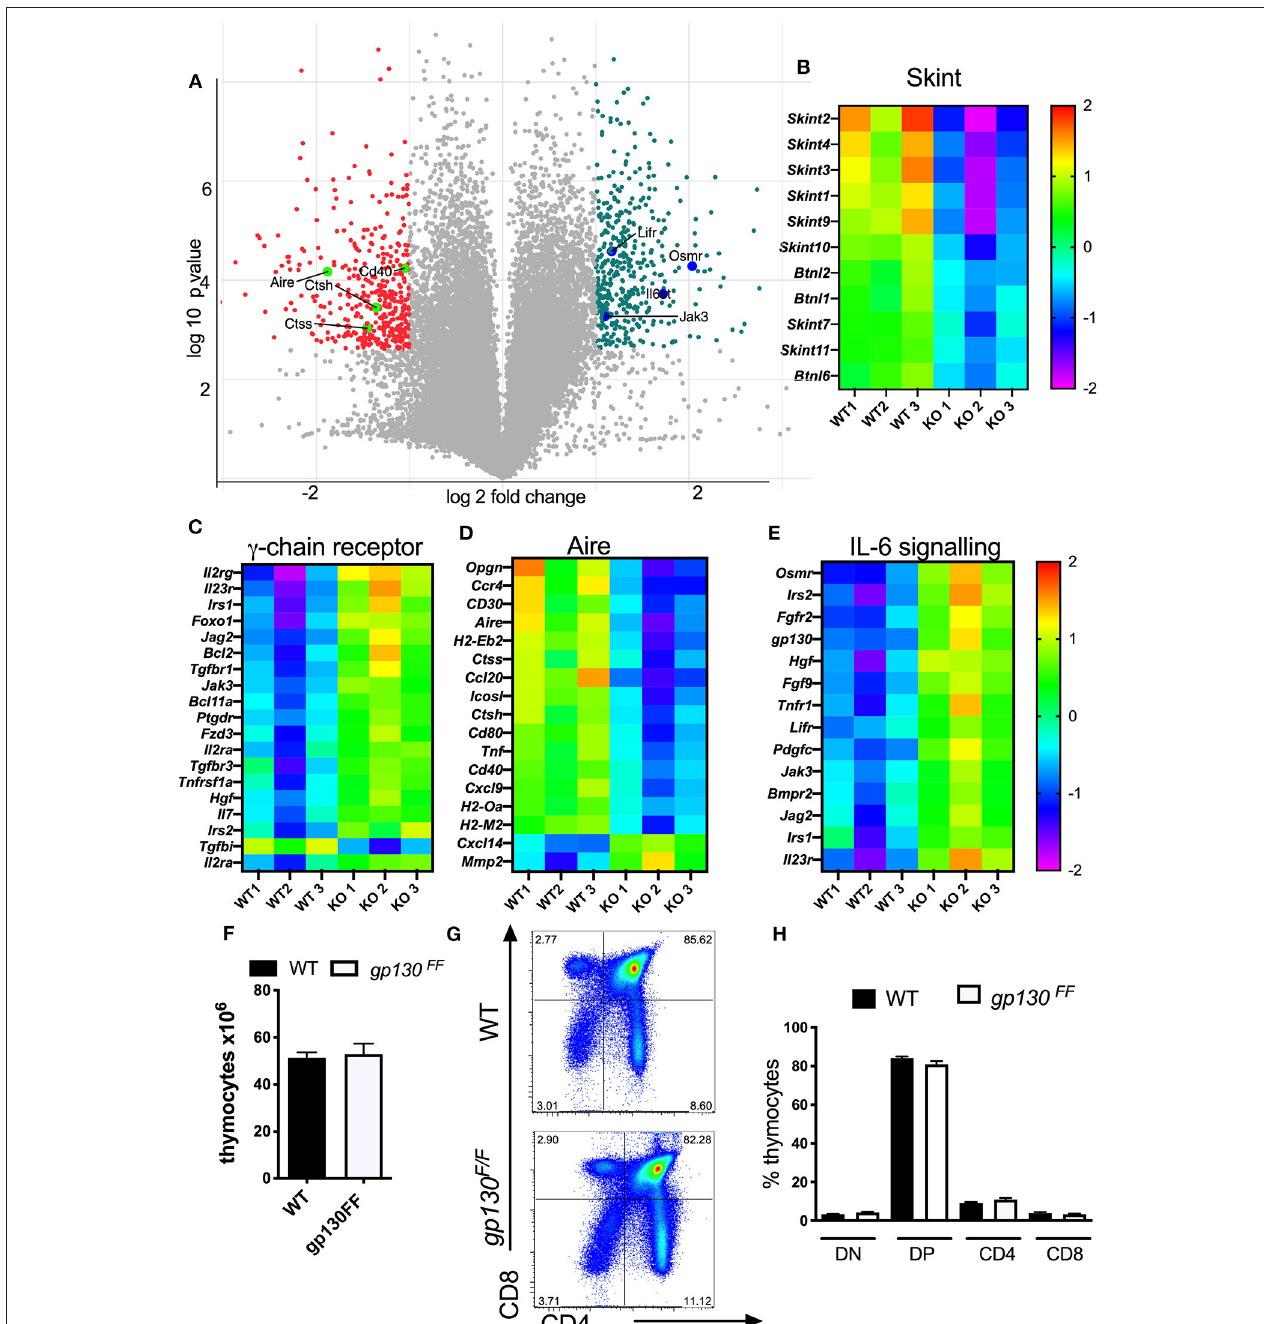
FIGURE 7 | 1 socs3 TECs show diminished expression of genes involved in T-cell selection and increased levels of those from the IL-6 family. (A) Volcano plot of the gene expression comparing the log 2 fold change (FC) differences and the statistical significance (log 10 probability) of transcript levels from three independent 1 socs3 and WT TECs samples. Highly dysregulated in absence of SOCS3 are labeled in pink. The Student-Newman-Keuls post-hoc test was used to identify the specific groups in which significant differential expression occurred. The heat maps of (B) skint, (C) common γ -chain receptor (D) aire, and (E) IL-6 signaling pathways representing transcript levels in mutant and control TECs are depicted. Data were normalized for each gene by mean subtraction of log 2 transformed values. Gene names are shown adjacent to heat maps. For all genes included in the heat maps, differences between WT and 1 socs3 TECS are statistically significant. (F) The mean thymocyte number, (G) a representative dot plot and (H) the frequencies of DN, DP, CD4, and CD8 SP thymocytes ± SEM in Gp130 F / F and WT mice ( n = 5 per group).